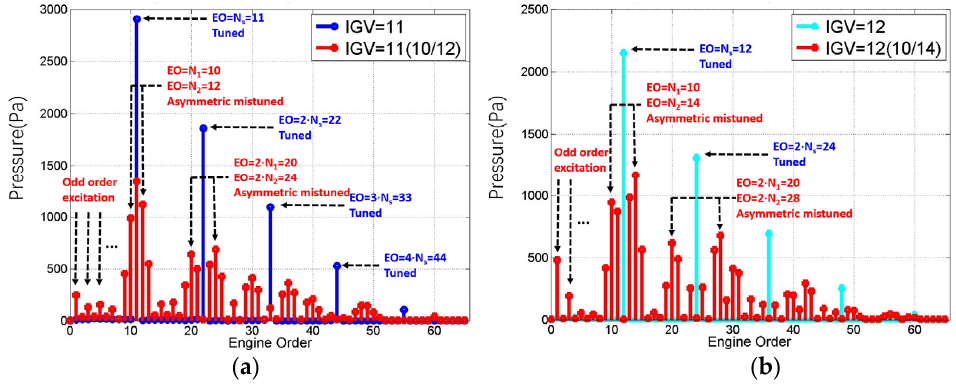
Figure 12. Frequency spectrum of asymmetric mistuned stators: ( a ) IGV = 11 ( 10/12 ) and ( b ) IGV = 12 ( 10/14 )